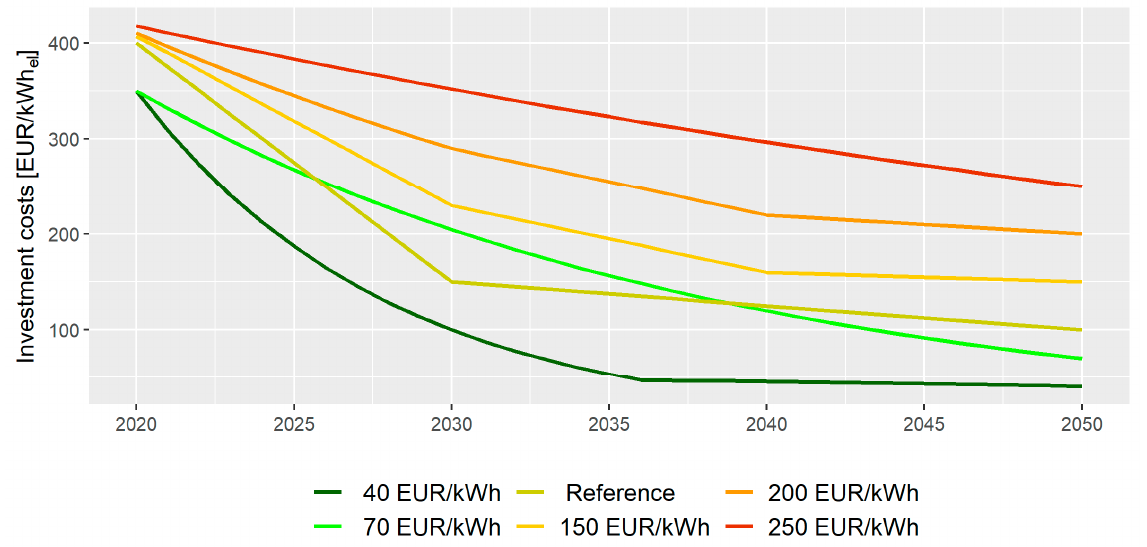
Figure 2. Variation of investment costs of stationary battery systems, in EUR/kWh (label corresponds to value in 2050).